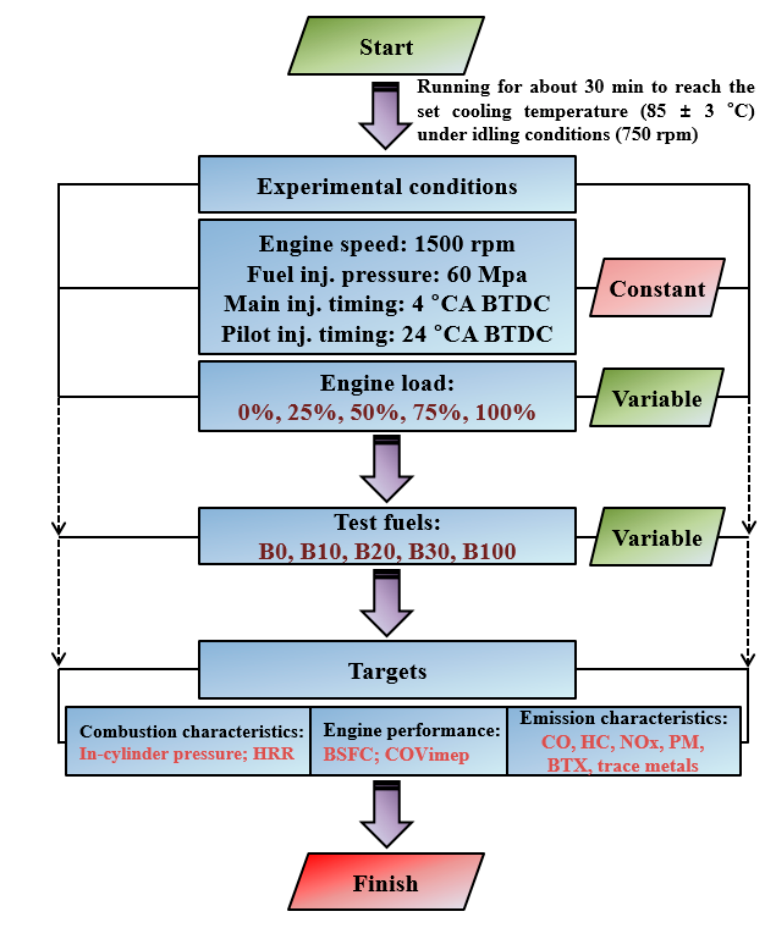
Figure 1. Schematic diagram of the experimental apparatus.